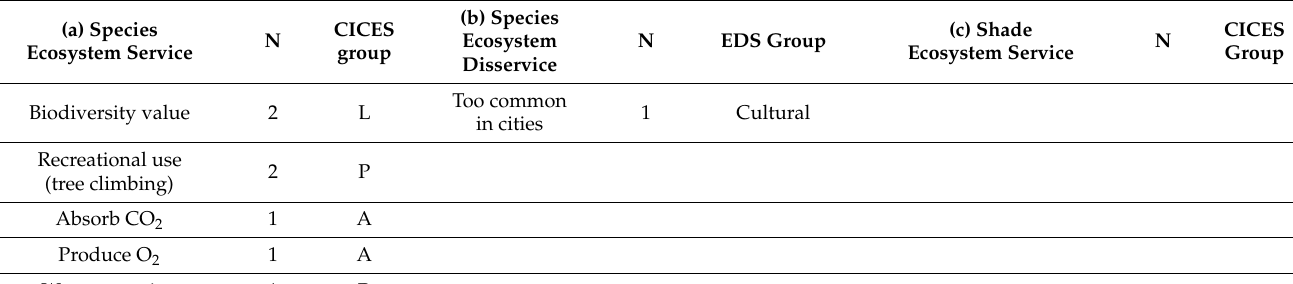
Table footnote: The Ecosystem Services are associated with the list of service groups in the Common International Classification of Ecosystem Services (CICES) V5.1 [31] coded as follows: A = Atmospheric composition and conditions, C = Cultivated terrestrial plants for nutrition, materials, or energy, I = Intellectual and representative interactions with natural environment, L = Lifecycle maintenance, habitat and gene pool protection, M 1 = Mediation of wastes or toxic substances of anthropogenic origin by living processes, M 2 = Mediation of nuisances of anthropogenic origin (e.g., sound), O = Other biotic characteristics that have a non-use value, P = Physical and experiential interactions with natural environment, R = Regulation of baseline flows and extreme events, S = Spiritual, symbolic and other interactions with nature. U* = Related to suitability for urban conditions. Categories for Ecosystem Disservices come from the classification proposed by Vaz et al.